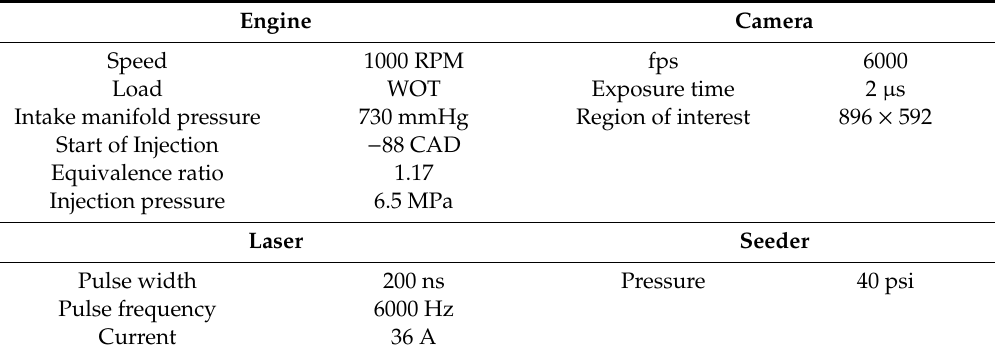
Table 5. Experimental settings for the presented results.